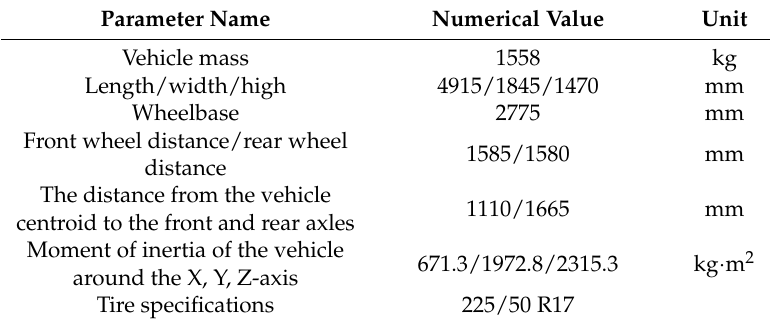
Table 3. Vehicle model parameters.